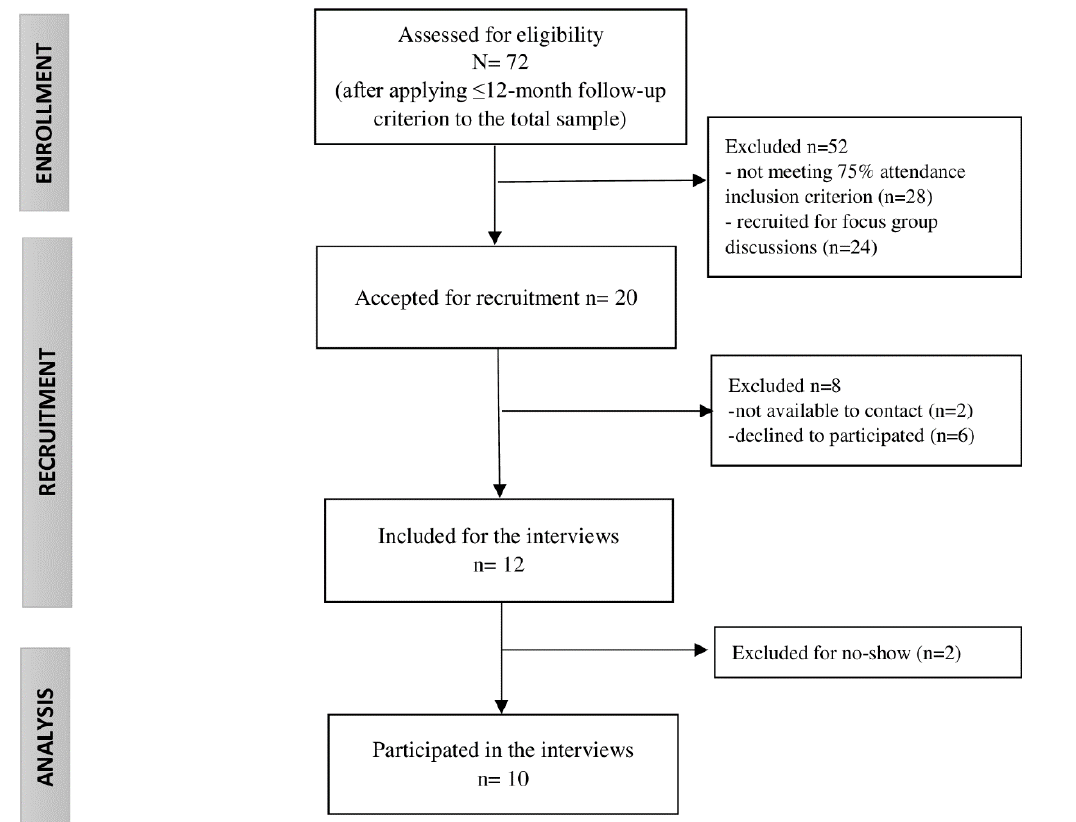
Figure 1. Study sample flow chart.